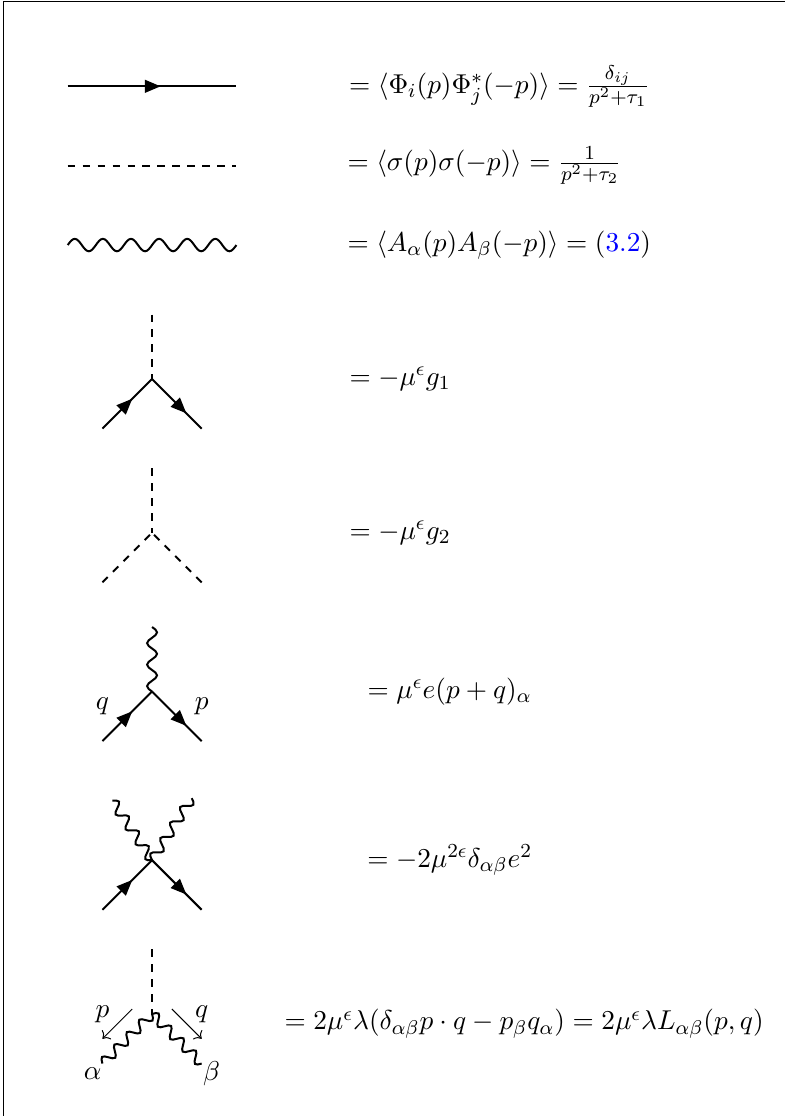
Table 1 . Feynman rules for tree-level propagators and